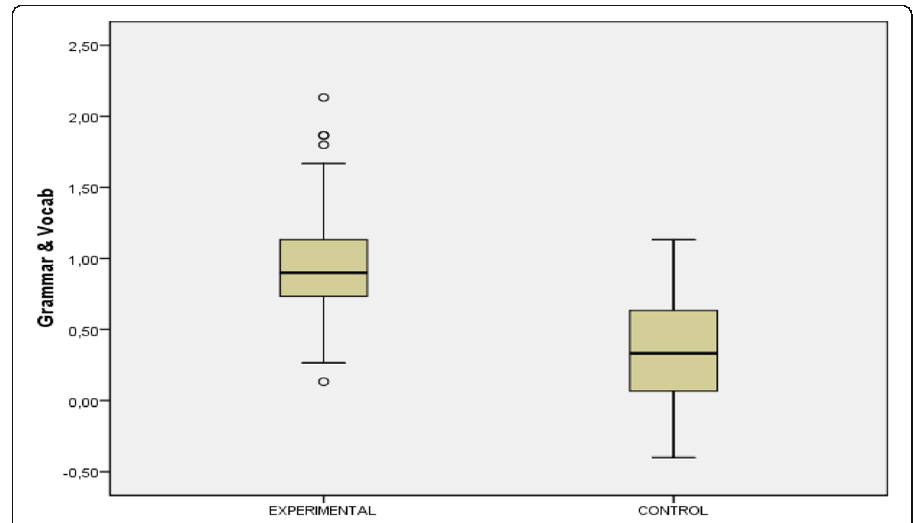
Fig. 7 Box-and-whisker plot of pre-treatment in variety and accuracy in grammar and vocabulary in both groups